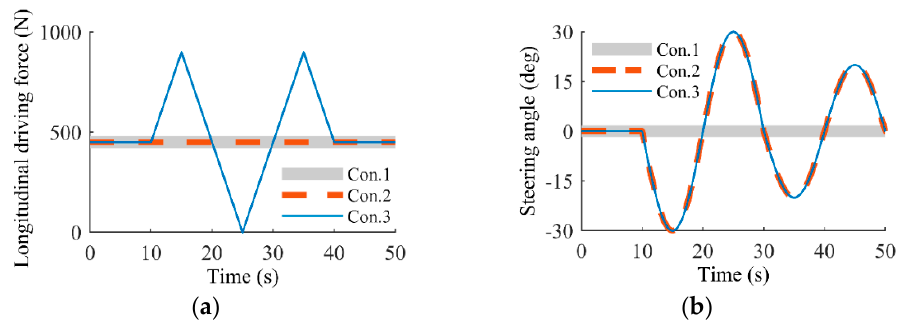
Figure 5 . Simulation inputs: ( a ) longitudinal driving force 𝐹 (cid:3021) ; ( b ) front wheel steering angle 𝛿 (cid:3033) . Figure 5. Simulation inputs: ( a ) longitudinal driving force F